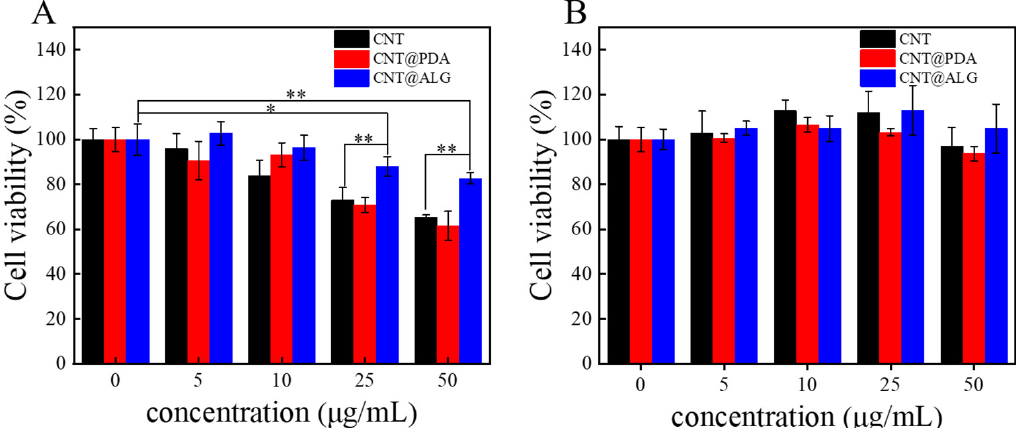
Figure 5. Cell viability of MC3T3-E1 cells ( A ) and HepG2 cells ( B ) cultured in suspensions of CNT, CNT@PDA, CNT@ALG at different concentrations. ( n = 5), * p < 0.05, ** p < 0.01.